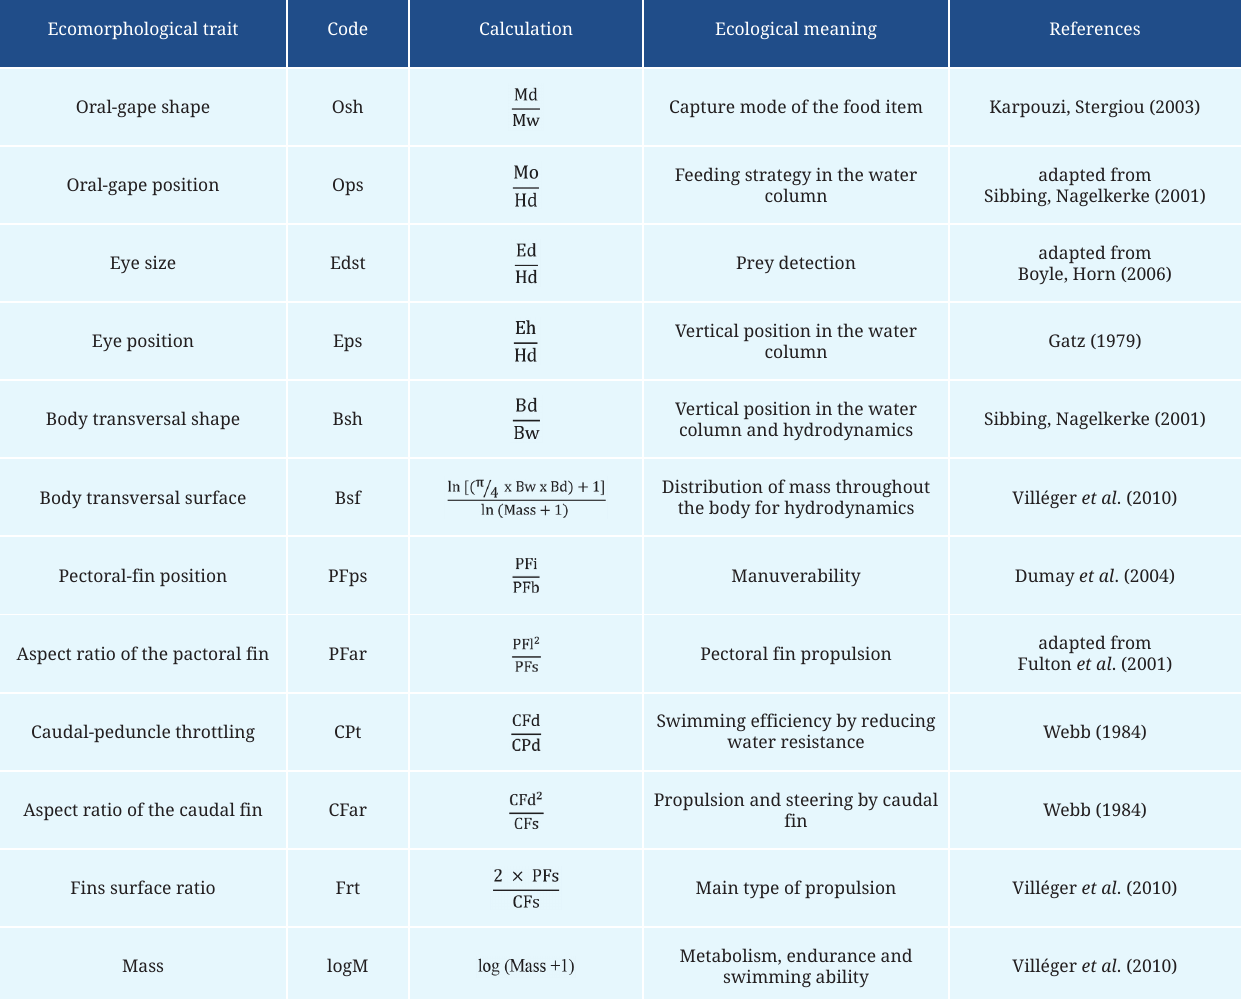
TABLE 2 | The 12 ecomorphological traits used to functionally characterize fish species of streams from the Araguari River basin and their ecological significance. Codes for the initial morphological measurements used to calculate traits according to Fig .